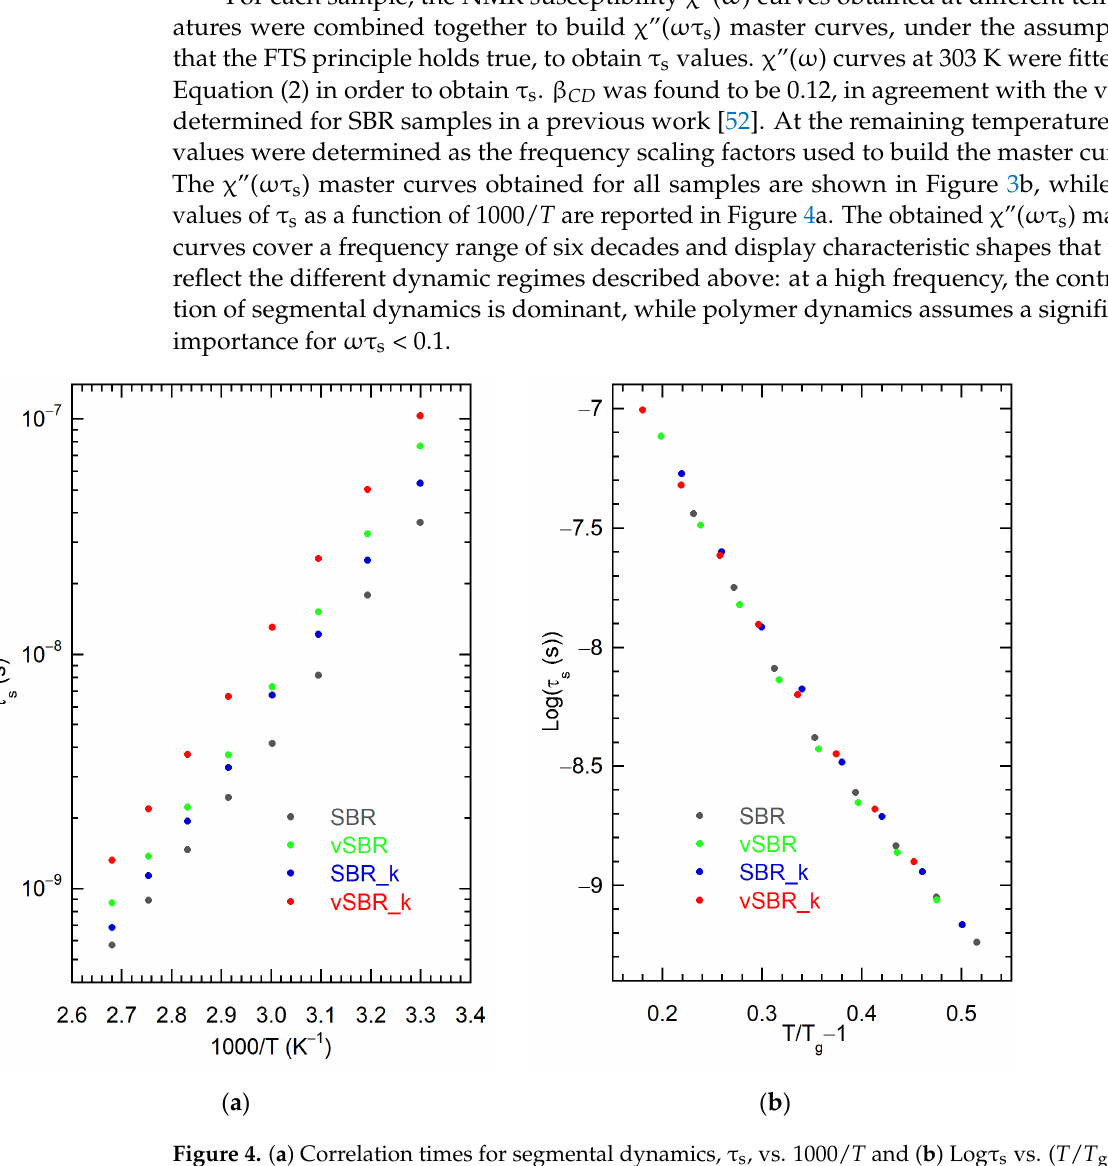
Figure 4. ( a ) Correlation times for segmental dynamics, τ s , vs. 1000/ T and ( b ) Log τ s vs. ( T / T g − 1) for the indicated samples. T g values were determined by DSC measurements (Table 2). Errors on τ s are lower than